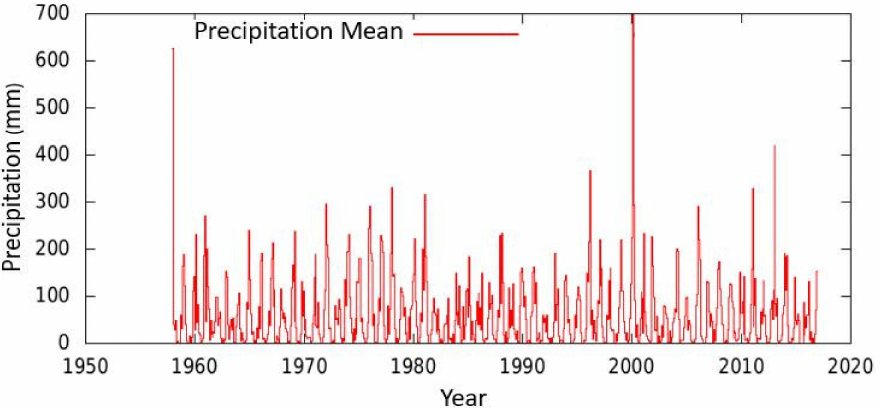
Figure 3. Mean interannual variability of precipitation over Mopani District (1958–2016). Source: Authors’ Field Data,